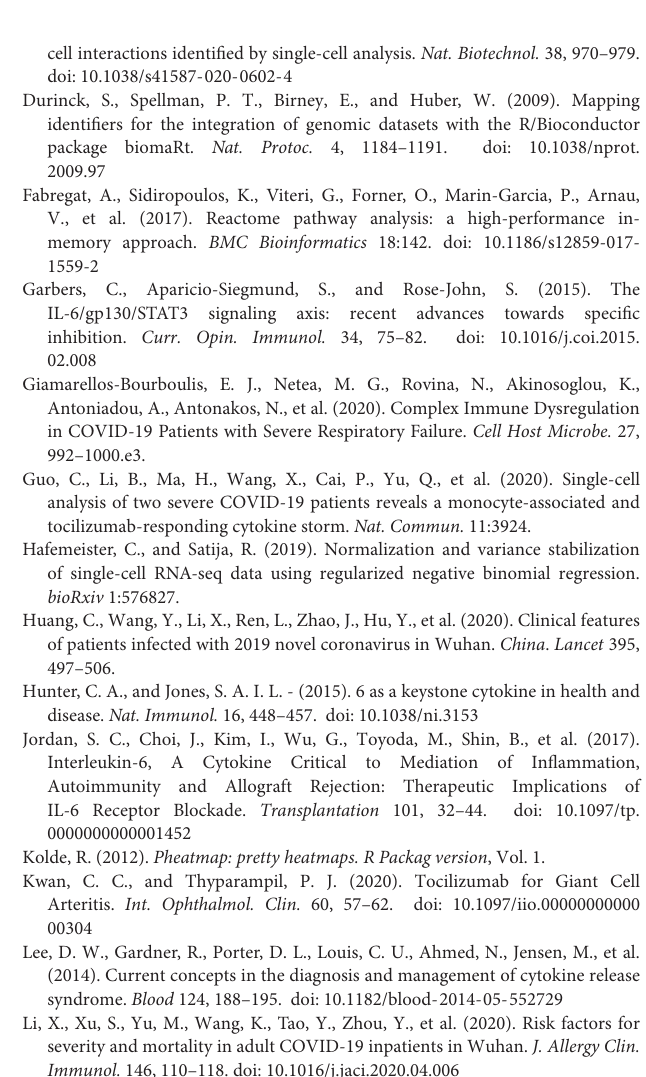
freemuxlet ID (bottom panel). (B) Scatter plot showing the expected linear increase in doublet rate with the increase in singlets; x -axis represents the total number of singlets and doublets and the y -axis represents the corresponding doublet rate. Supplementary Figure 2 | Feature plots of canonical markers used for cluster annotation. Genes expression represented by color gradient, with highest expression represented by blue, and lowest expression represented by gray. Supplementary Figure 3 | UMAP of all cells, annotated by patient sex. UMAP plot of all cells, annotated by patient sex; although there is a greater proportion of male cells based on trial including more males, there is no clear pattern of clustering based on patient sex. Supplementary Figure 4 | Reactome pathway analysis tables. (A) Monocyte Reactome pathway analysis table with enriched Reactome pathways. (B) CD4 + T cell Reactome pathway analysis table with enriched Reactome pathways. (C) CD8 + T cell Reactome pathway analysis table with enriched Reactome pathways; columns included are Reactome pathway name, number of enriched genes that are present for that respective pathway, gene ratio (the number of genes present in the respective pathway divided by the total number of genes in the pathway), and the adjusted p -value for significant pathways; only pathways with an adjusted p -value < 0.05 were included.